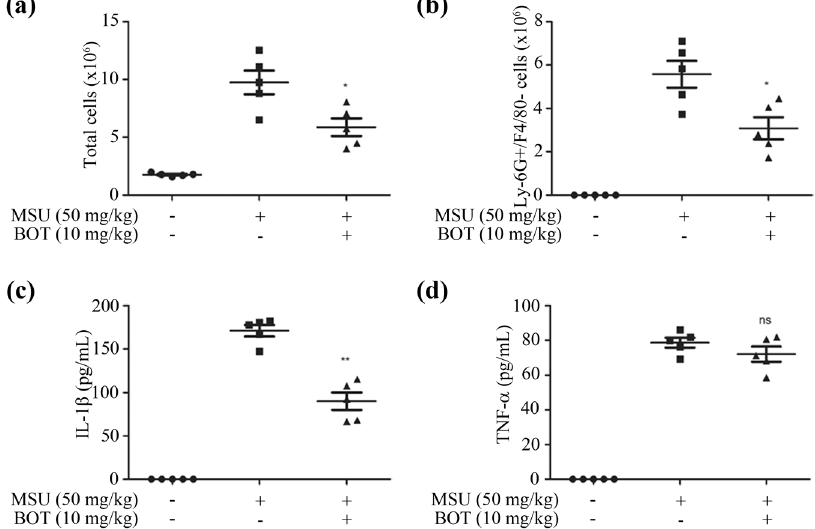
Figure 7. BOT-4-one suppresses MSU-induced peritonitis in vivo model. C57BL/6 mice were given an intraperitoneal injection of BOT-4-one successively 2 and 12 h before infection with MSU. ( a ) Peritoneal lavage fluids were collected at 6 h after the MSU challenge to measure the total number of cells. ( b ) Ly-6G + /F4/80 − cells were measured by flow cytometry. Concentrations of IL-1 β ( c ) and TNF- α ( d ) in the peritoneal lavage fluids were measured with ELISA. The data represent the mean ± SEM of three independent experiments; * p < 0.05; ** p < 0.01; ns: